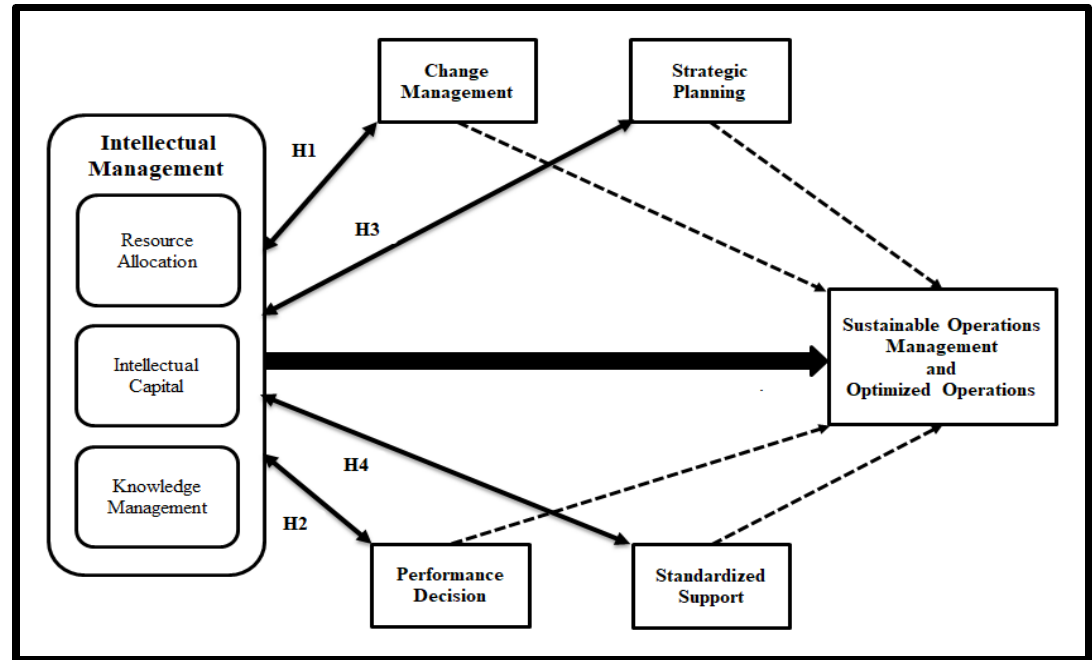
Figure 3. Proposed conceptual